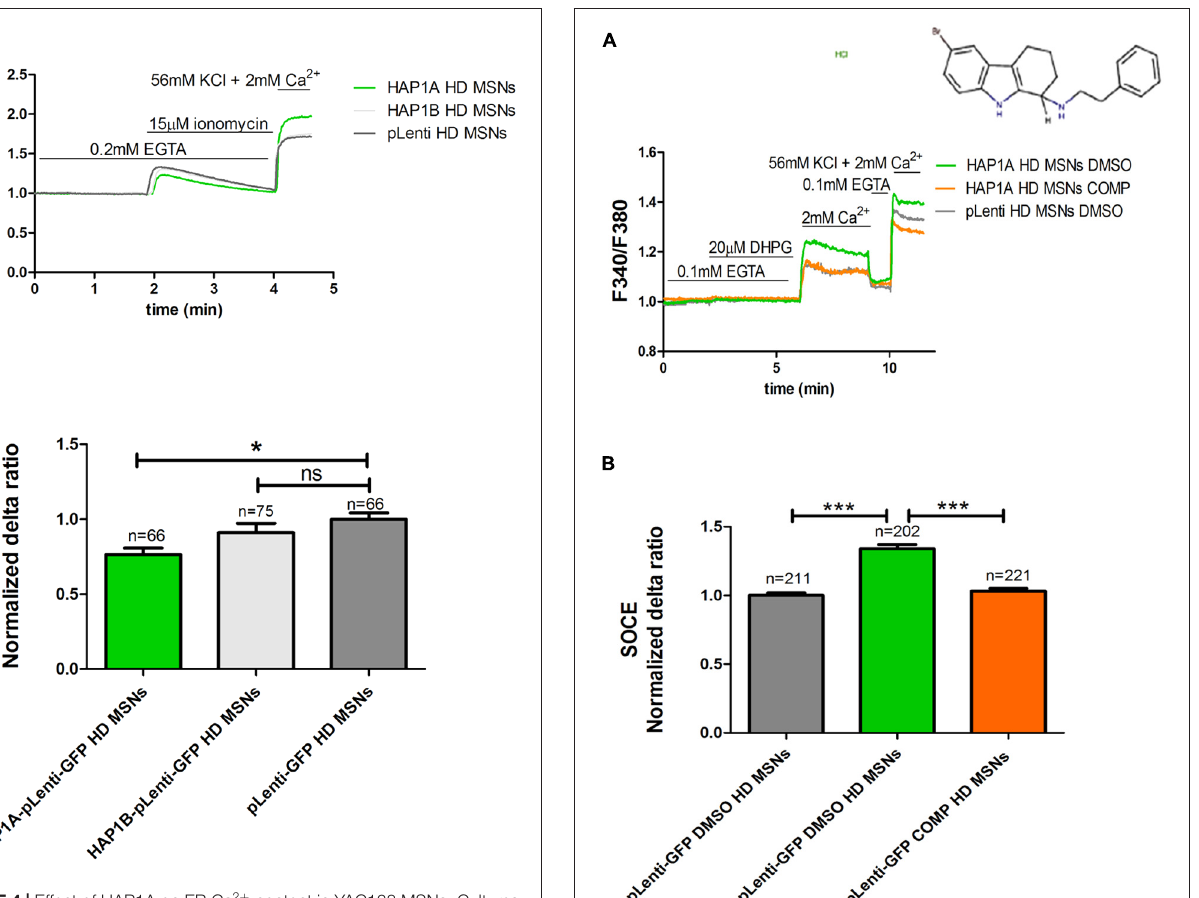
FIGURE 4 | Effect of HAP1A on ER Ca 2 + content in YAC128 MSNs. Cultures of MSNs on DIV14 from YAC128 mice that overexpressed HAP1A-pLenti-GFP, HAP1B-pLenti-GFP, or pLenti-GFP using lentiviruses that were loaded with the Ca 2 + indicator Fura-2AM. (A) The figure shows the protocol to induce ionomycin-induced Ca 2 + release from the ER in YAC128 MSNs that overexpressed HAP1 isoforms using the eight-well system. YAC128 MSNs that overexpressed HAP1A isoforms were incubated in Ca 2 -free medium (0.1 mM EGTA), followed by 15 µ M ionomycin application to induce the release of Ca 2 + . KCl (56 nM) in 2 mM Ca 2 + was applied to distinguish neurons from glial cells. (B) Ionomycin-induced ER Ca 2 + release in YAC128 MSNs that overexpressed HAP1 isoforms. The results are expressed as mean ± SEM. The number of cells is shown on the top of the bars. ∗ p < 0.05. ns, not significant. The results were obtained from three independent MSN culture preparations.